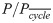
Normalized relative pressure, P/Pcycle¯, and normalized velocity magnitude, Umag/Ucycle¯, at the phantom centerline.Each blue line represents velocity distribution at the centerline in one phase from diastole (light blue) to systole (dark blue) with the dashed blue line showing the cycle-averaged velocity. The red color coding shows the pressure distribution at the centerline in the same fashion. The centerlines shown at the top right and bottom right are respectively colored by the local systolic velocity and systolic pressure from blue (low) to red (high).